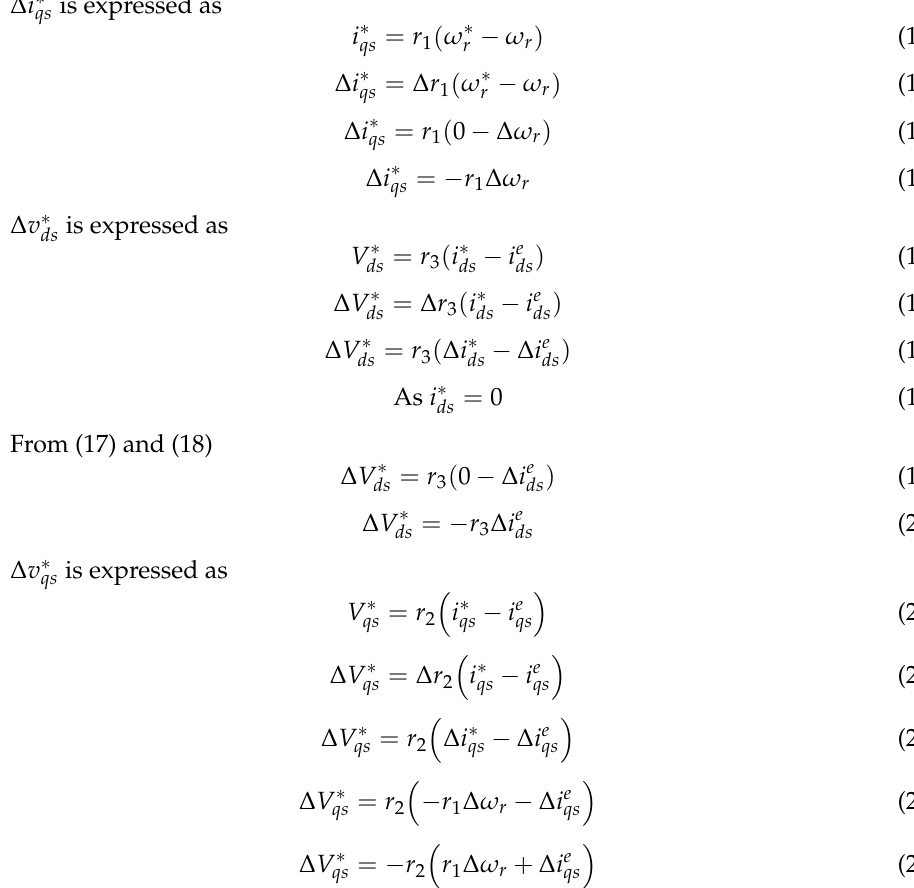
Figure 2. Schematic diagram of the speed sensor vector-controlled PMSM drive with the current sensorless scheme .